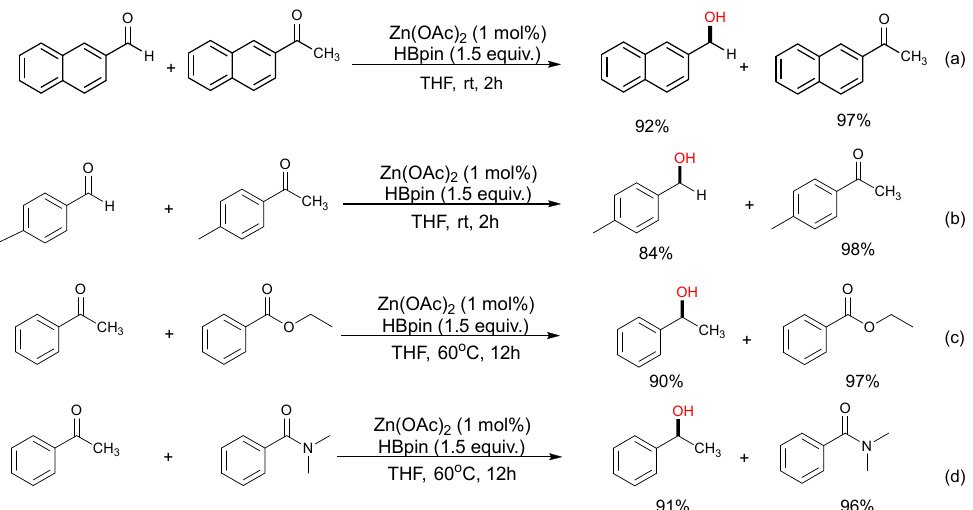
Scheme 6. Intermolecular chemoselective reduction of carbonyl substrate: ( a ) Intermolecular chemoselective of 2-naphthaldehyde and 2-acetonaphthone; ( b ) Intermolecular chemoselective of 4-methylbenzaldehyde and 4-methylacetophenone; ( c ) Intermolecular chemoselective of acetophenone and ethyl benzoate; ( d ) Intermolecular chemoselective of acetophenone and N , N -